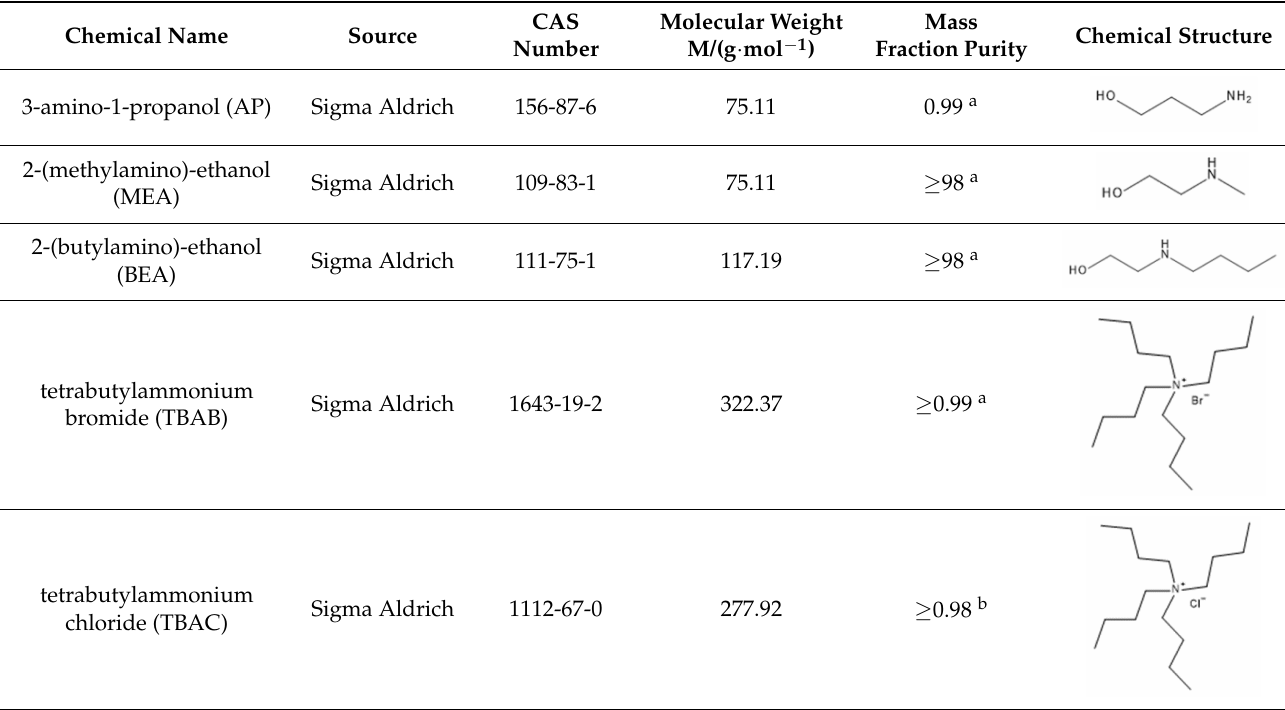
Table 1. Provenance, mass fraction purity, and chemical structures of the compounds